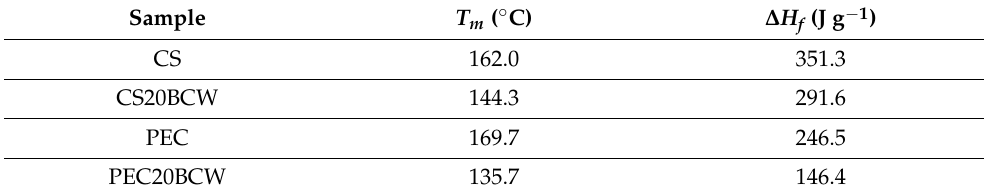
Table 4. Melting temperatures ( T m ) and heats of fusion ( Δ H f ) of tested film formulations. Sample